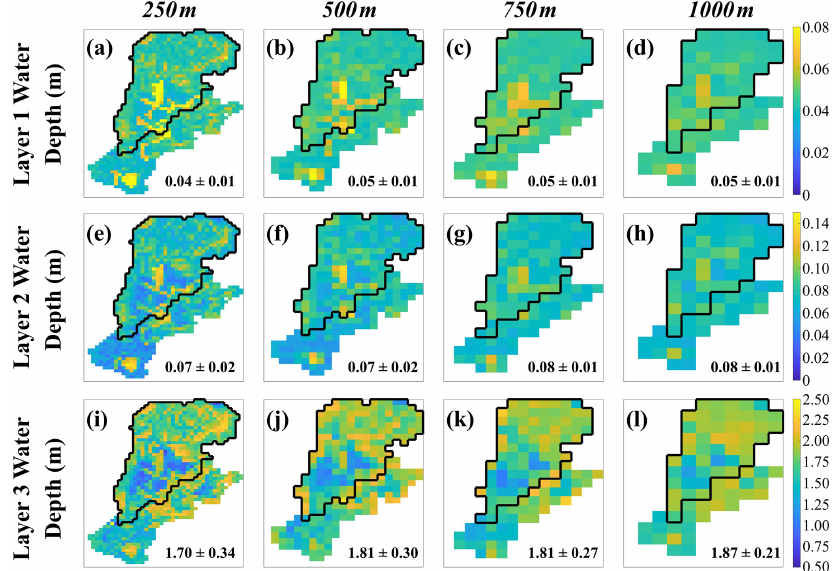
Figure 6. The (a–d) median annual equivalent water depth in layer 1, (e–h) median annual equivalent water depth in layer 2, and (i–l) median annual equivalent water depth in layer 3 for the 250, 500, 750, and 1000m resolutions. Black boundaries show the calibration extent of the Demnitz Mill subcatchment. Values shown are the catchment-wide, long-term (2009–2019) median values and average standard deviation (average of pixel standard deviation) within the Demnitz Mill subcatchment.